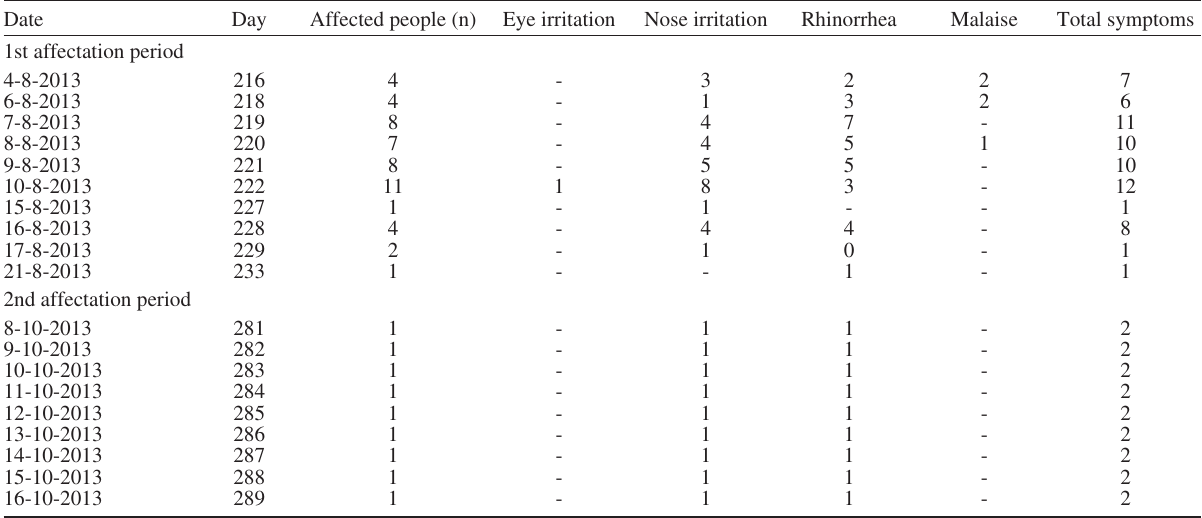
Table 2. – Symptoms reported by the human cohort (16 people) during the